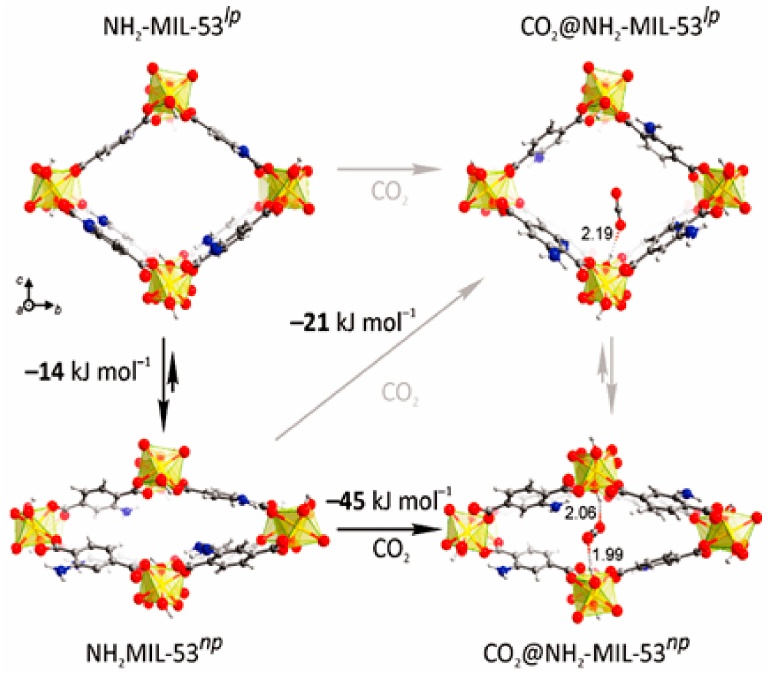
Figure19. Structures andrelativeenergiesofNH 2 -MIL-53materials andtheircomplexeswith CO 2 [145]. Pressure swing separation is an essential application for flexible MOFs